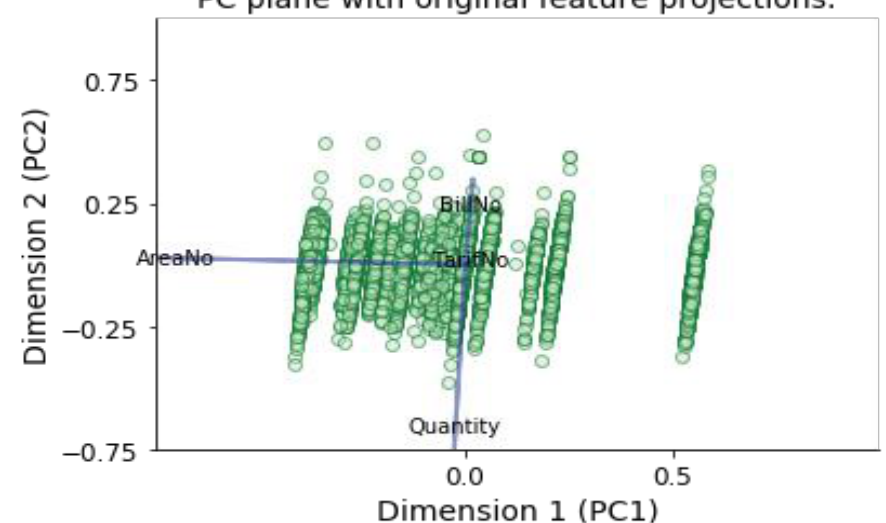
Figure 9. PC plane with original feature